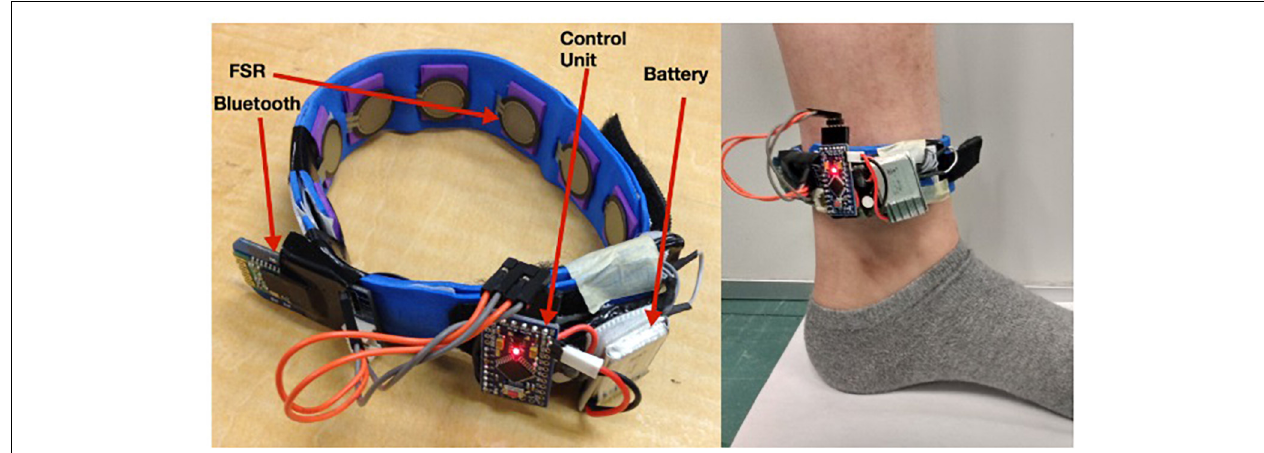
FIGURE 4 | An FSR sensor-based force myography band for gait application [Reproduced with permission from Jiang (2018), Memorial University of